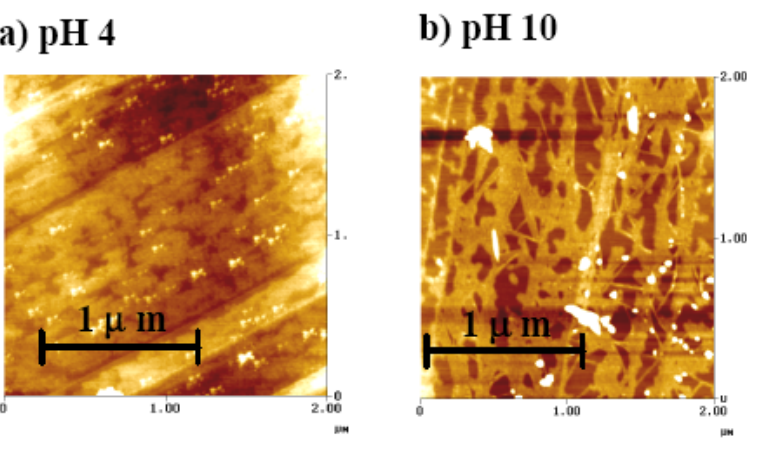
conjugated on the surface of 20 nm gold colloid 1-40